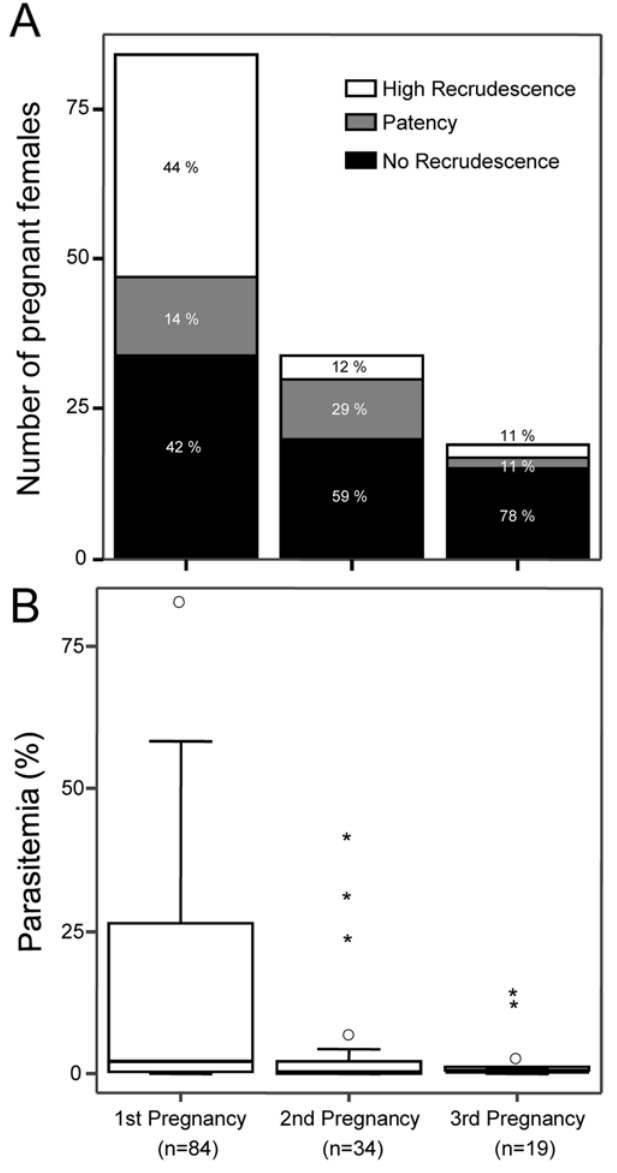
Figure 5. Recrudescence incidence and peripheral parasitemia are decreased in multigravida. (A) Frequency of females with high recrudescence (above 5% parasitemia), patency (parasitemia between 1% and 5%) and no recrudescence (parasitemia , 1%) according to parity. Recrudescence incidence is significantly associated with parity ( P -value=0.001, Chi-square test). (B) Box-plots illustrate the range of the peripheral parasitemia peak according to parity. The parasitemia peak in the first pregnancy was significantly different from the second ( P - value=0.004) and third pregnancies ( P -value=0.006). * and # represent extremes and outliers,